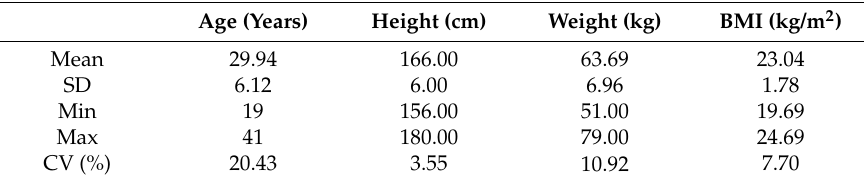
Table 2. Linearity, precision and accuracy for detection of diosmetin in plasma